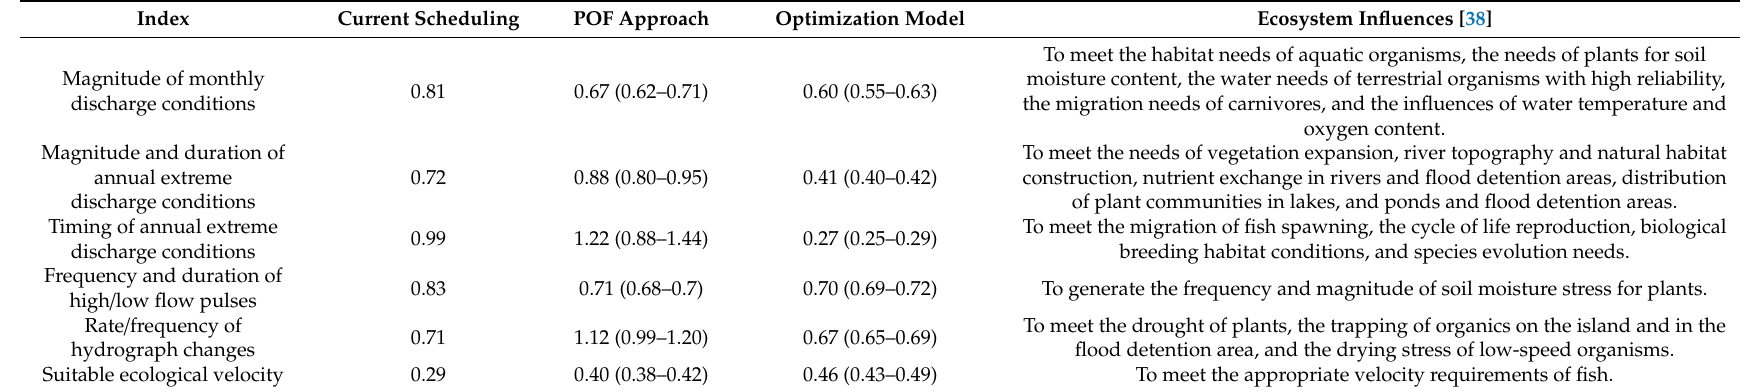
Table 3. Quantitative evaluation of the